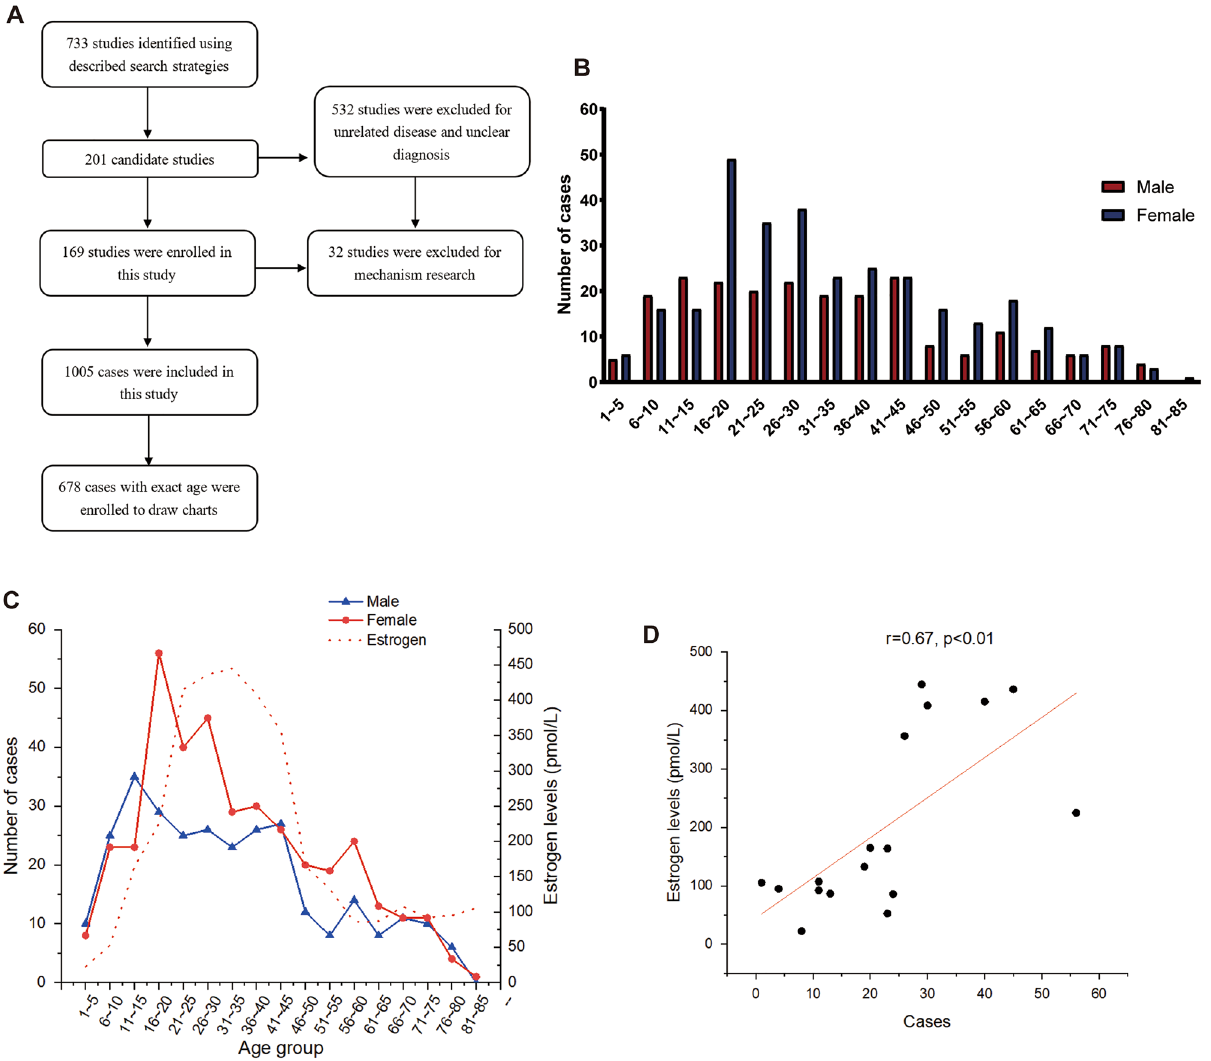
Figure 1. Similar trends between the onset trend of female and estrogen physiological rhythm in Xp11.2 tRCC. ( A ) Flow diagram of study selection. ( B ) The gender distribution in different age groups. ( C ) The trend of the onset time of Xp11.2 tRCC cases in female and estrogen levels. ( D ) Correlation analysis of the trends of female cases and estrogen changing trend with age. n.s.: p ≥ 0.05; *p < 0.05; **p < 0.01; ***p < 0.001; ****p <